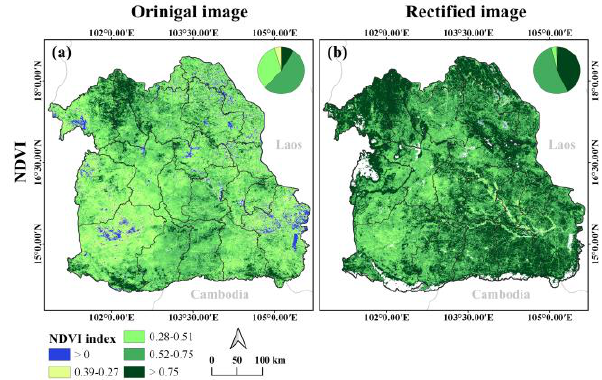
Figure 4. Comparison of MODIS NDVI image time series